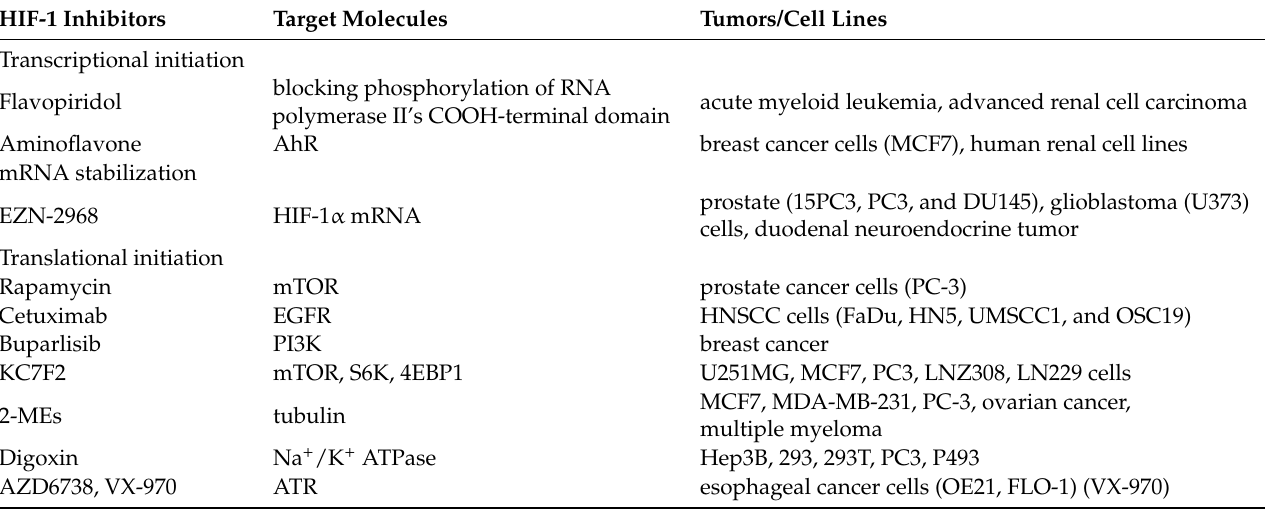
Table 1. Potential HIF-1 inhibitors under development.